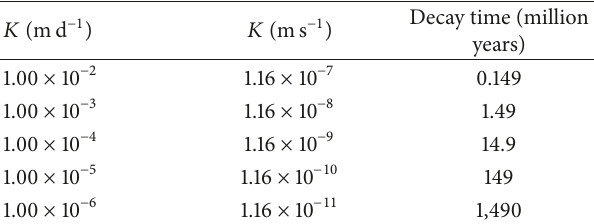
Figure 29: Results of running the second model, the 18 Ma model, representing the 9-million-year period from 27 to 18Ma, com- pared to present-day heads. Model curves (1) , (2) , and (3) (Wolf- campian, Desmoinesian, and Mississippian, resp.) are approaching the present-day data curves. Red triangles at centroids of the grid columns mark the initial zero heads at 70 Ma. Table 6: Analytical solution for decay time to steady state in the west as a function of hydraulic conductivity, based on equations in Carslaw and Jaeger [17].